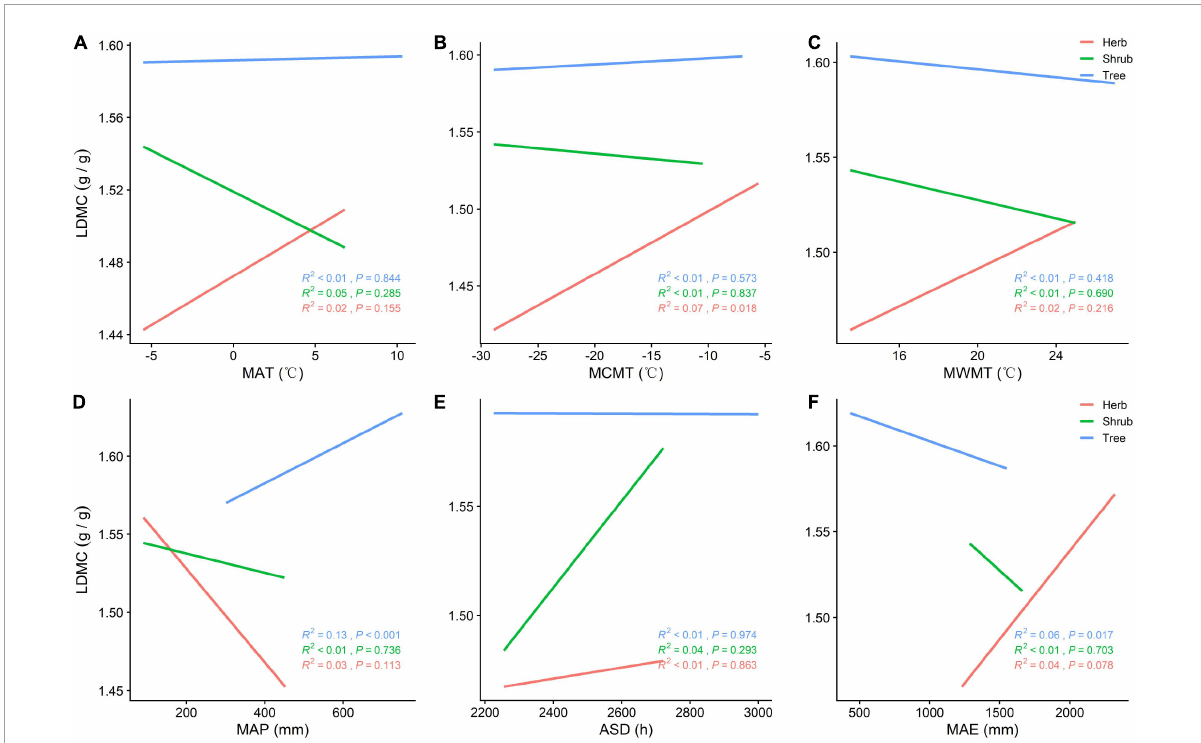
FIGURE4 (A) General linear relationship between MAT and LDMC of plants in the trees, shrubs, and herbs; (B) general linear relationship between MCMT and LDMC of plants in the trees, shrubs, and herbs; (C) general linear relationship between MWMT and LDMC of plants in the trees, shrubs, and herbs; (D) general linear relationship between MAP and LDMC of plants in the trees, shrubs, and herbs; (E) general linear relationship between ASD and LDMC of plants in the trees, shrubs, and herbs; (F) general linear relationship between MAE and LDMC of plants in the trees, shrubs, and